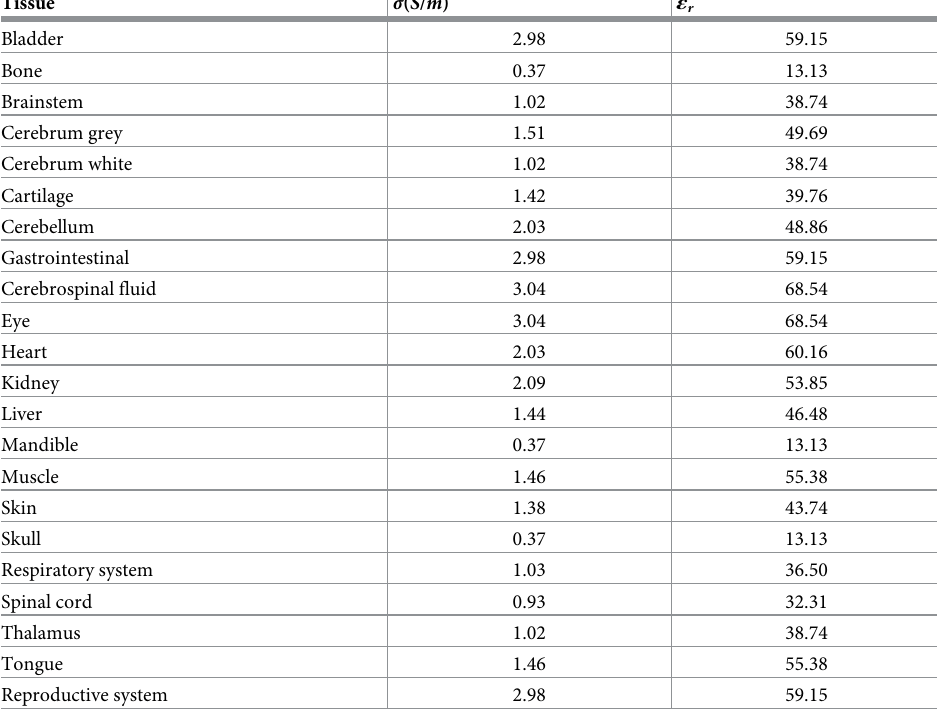
Table 2. Tissue relative permittivity and